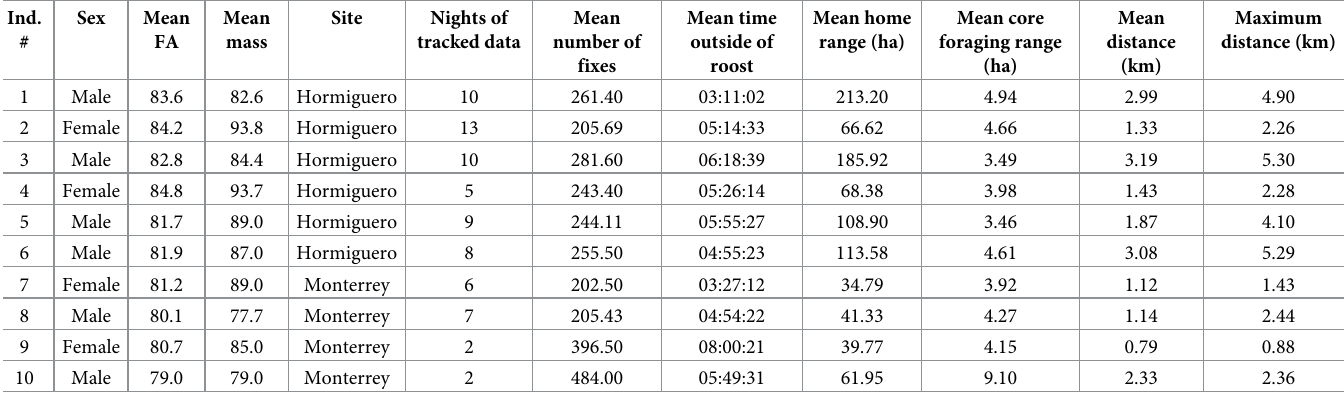
Table 1. Description of the captured and tagged Chrotopterus auritus per site and